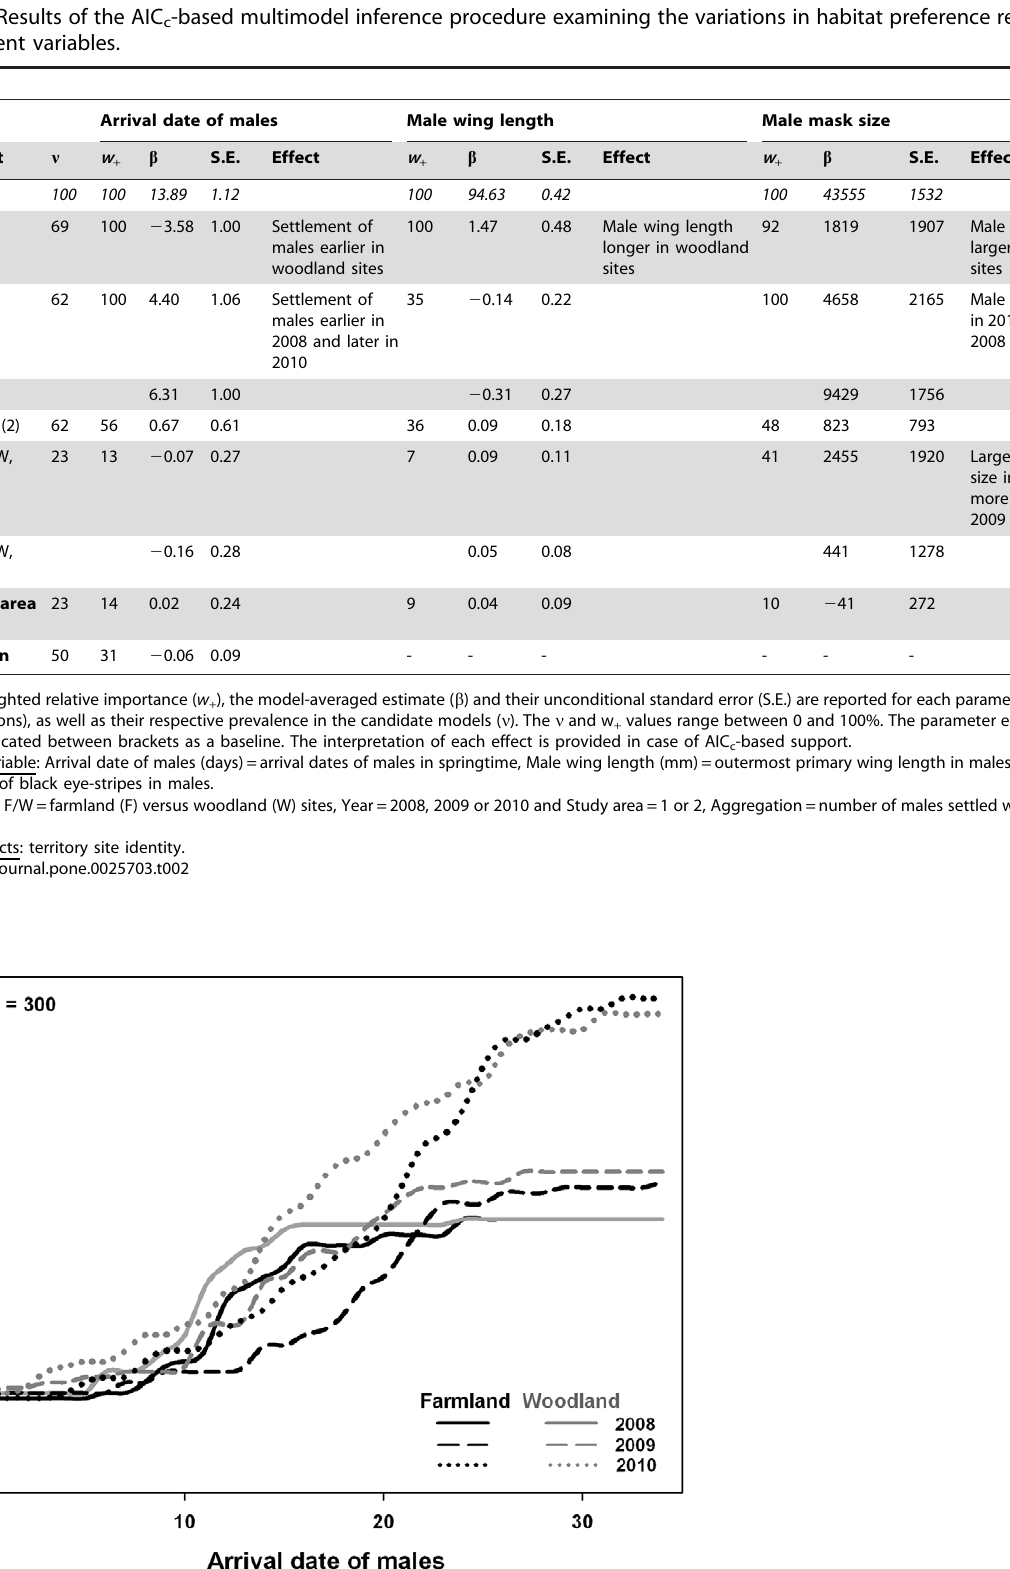
Figure 1. Cumulative number of territories occupied by males along the breeding season in farmland and woodland sites. The date corresponding to the first arrival within each year is set to 0.